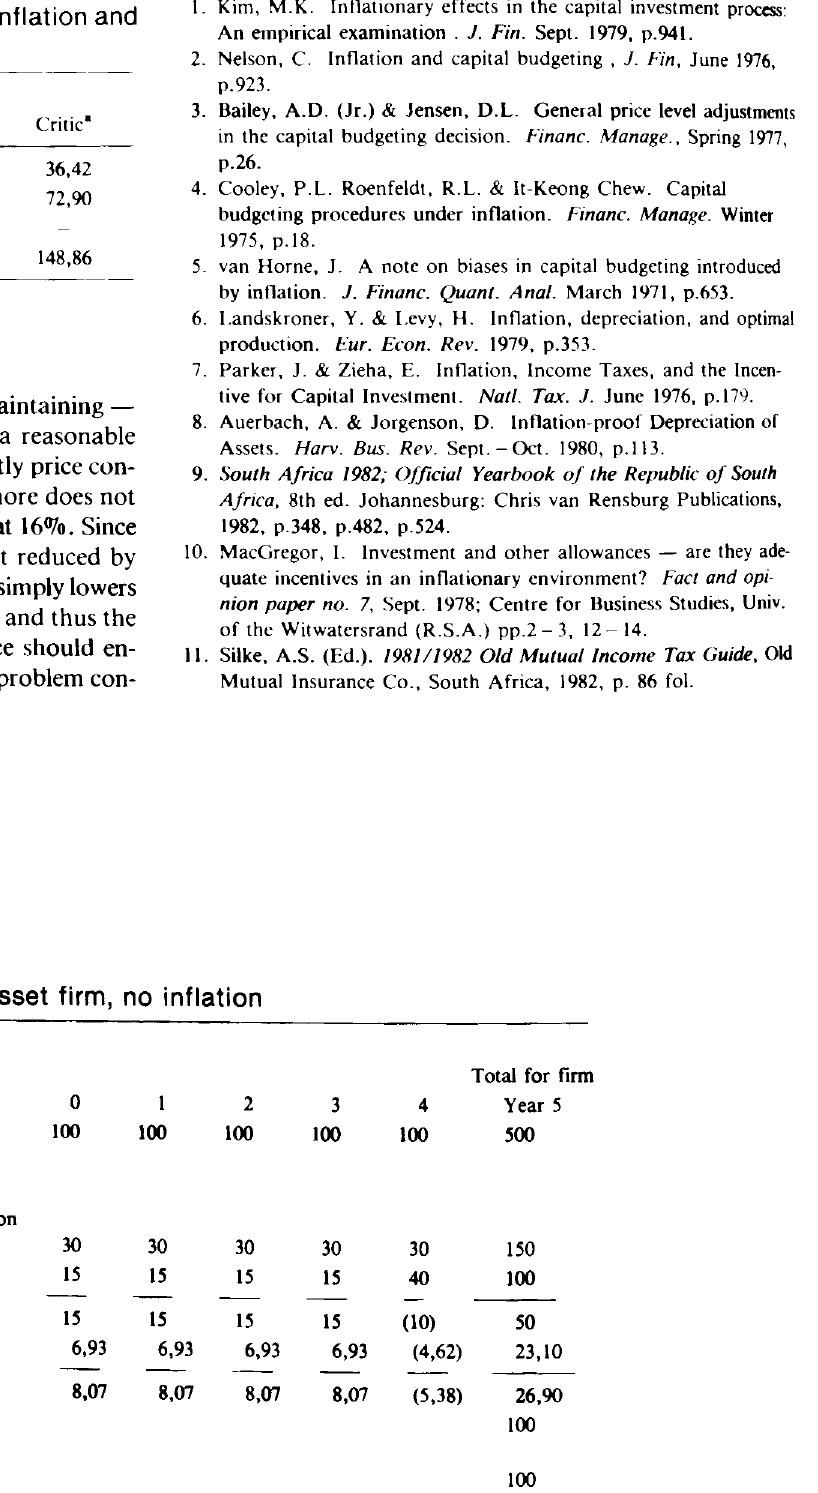
and M with critic's 1 2